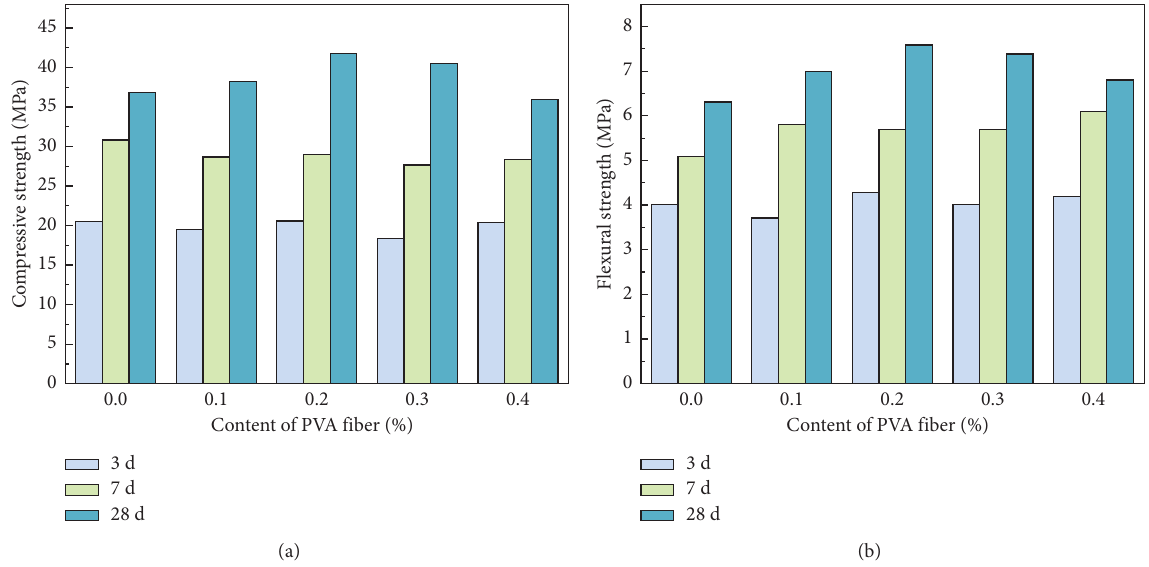
Figure 3: Strength of geopolymers with different PVA fibre contents. (a) Compressive strength and (b) flexural